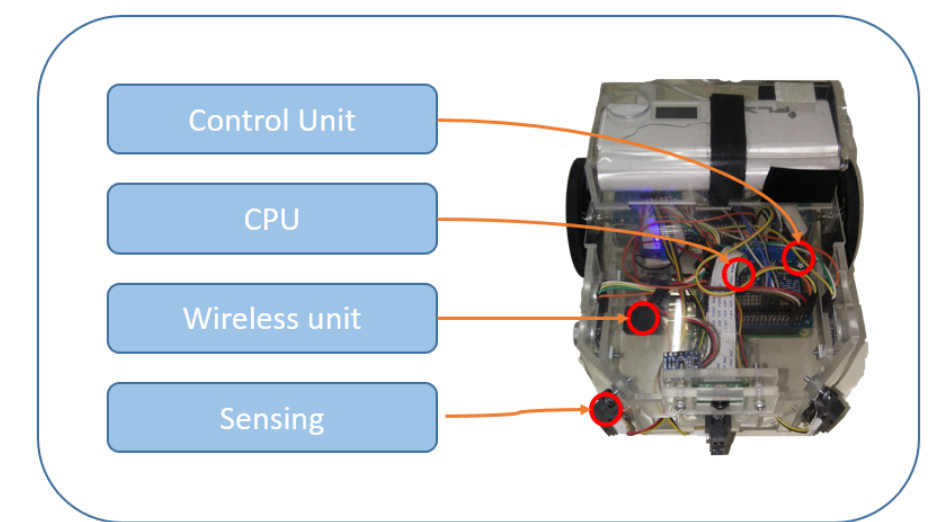
Figure 1. Robotic agent diagram.